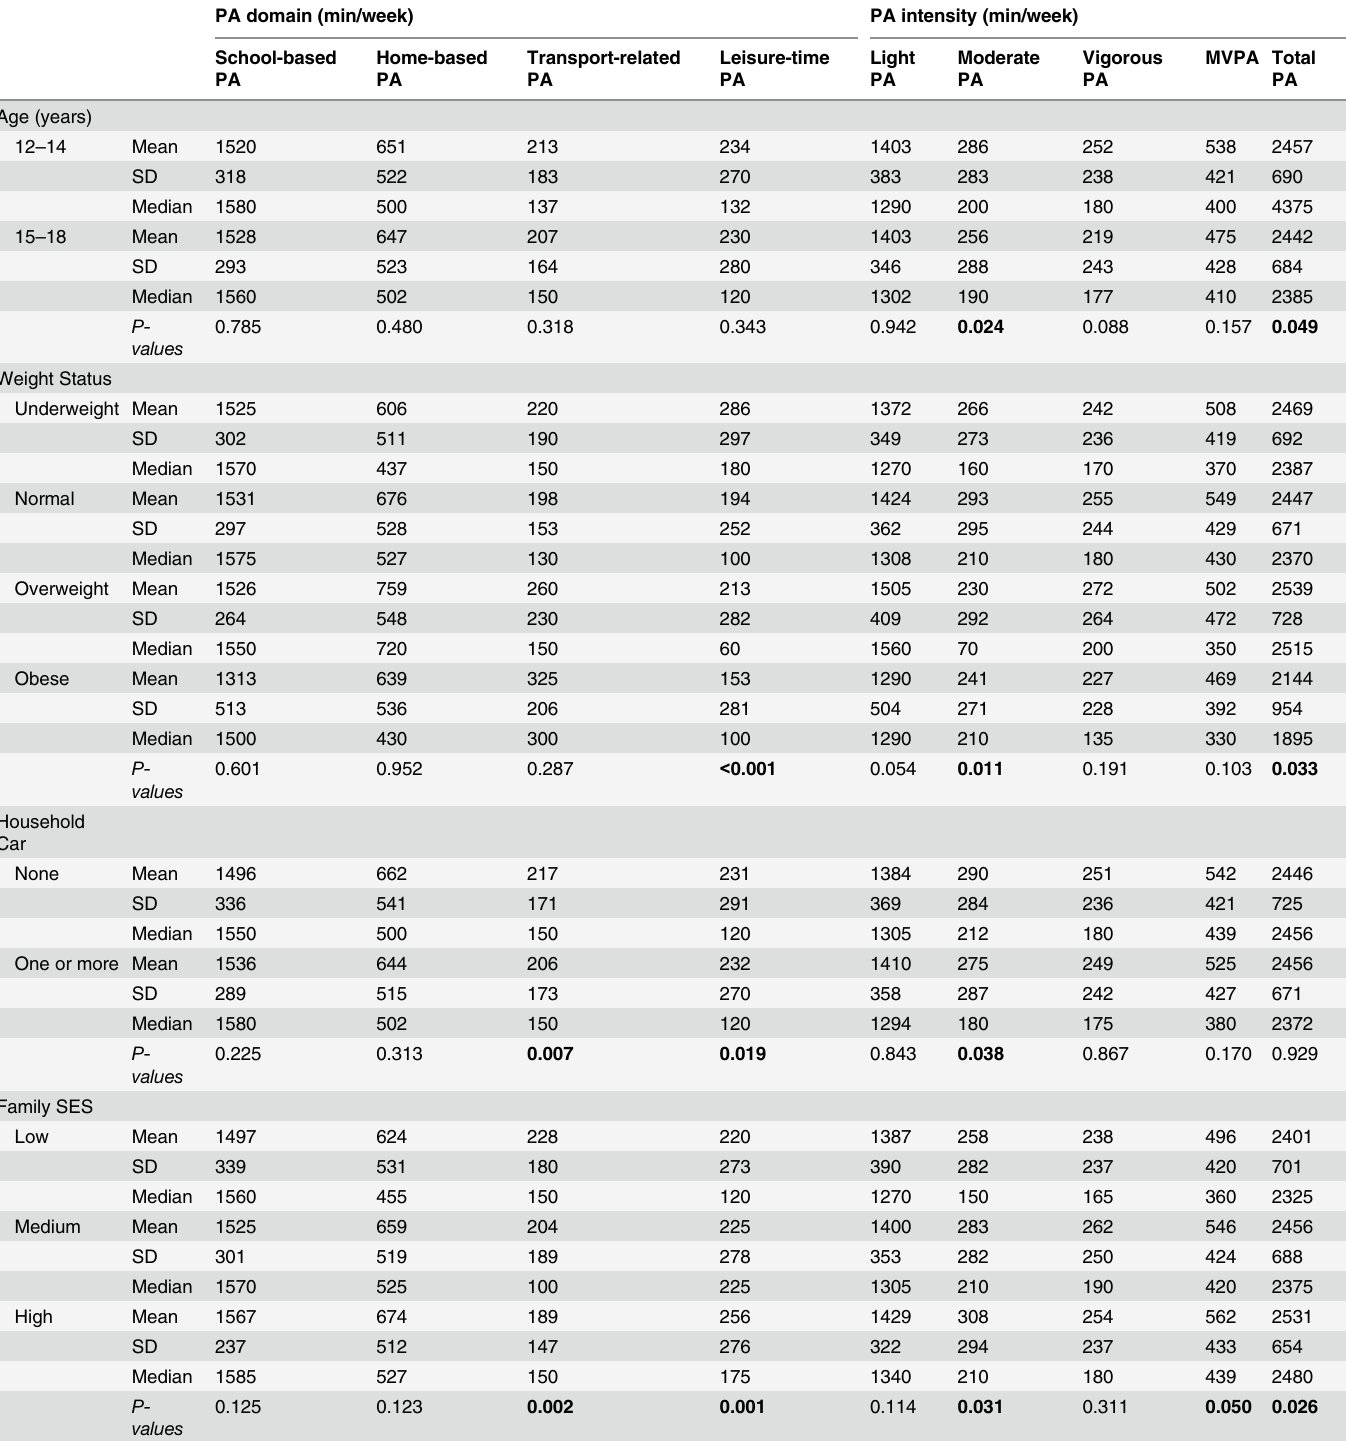
Table 3. Physical activity per domain and intensity for groups based on age category, weight status, household cars and family SES. PA domain